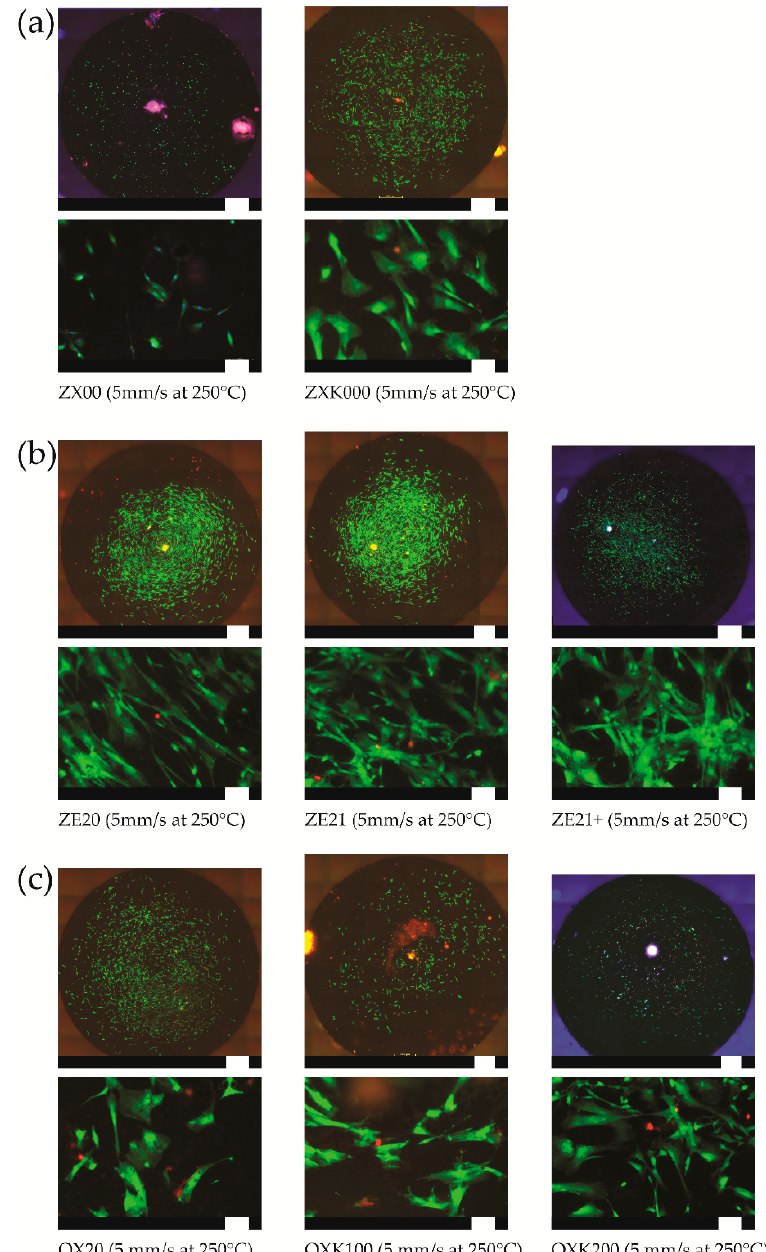
Figure 8. Live/dead staining of human umbilical cord perivascular cells (HUCPV) cultured on the different materials. ( a ) ZX-, ( b ) ZE-, and ( c ) QX-series. For each material, an overview micrograph (scale bar 1 mm) and a representative view with higher magnification (below the overview; scale bar 100 µm) are presented.